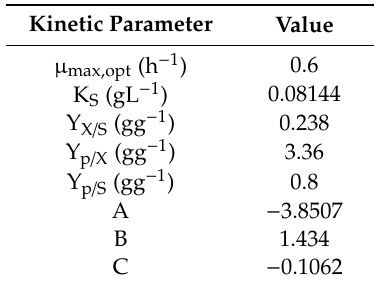
Table 5. Values of kinetic